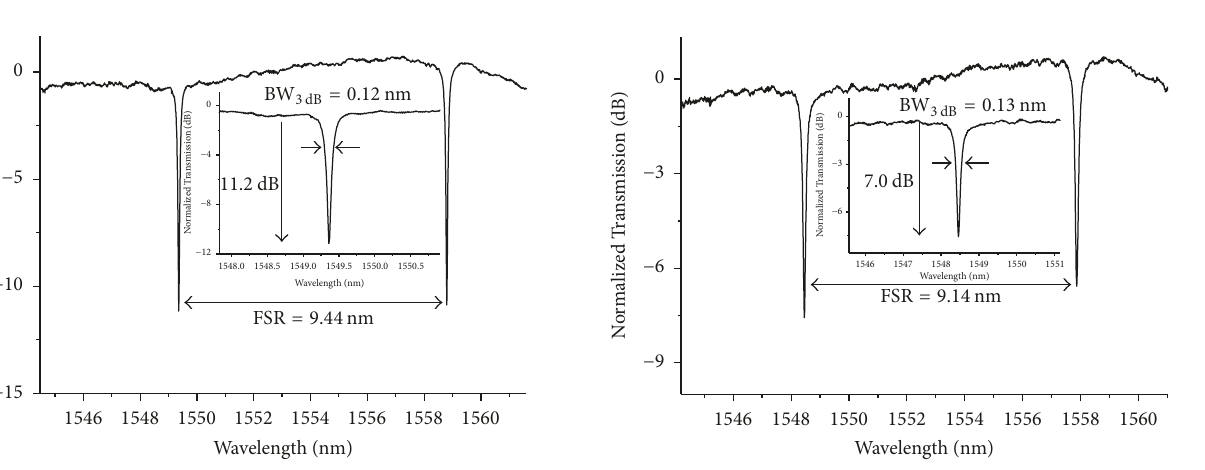
Figure 9: The transmission spectrum of the micro-nano SOI micro- ring electro-optic